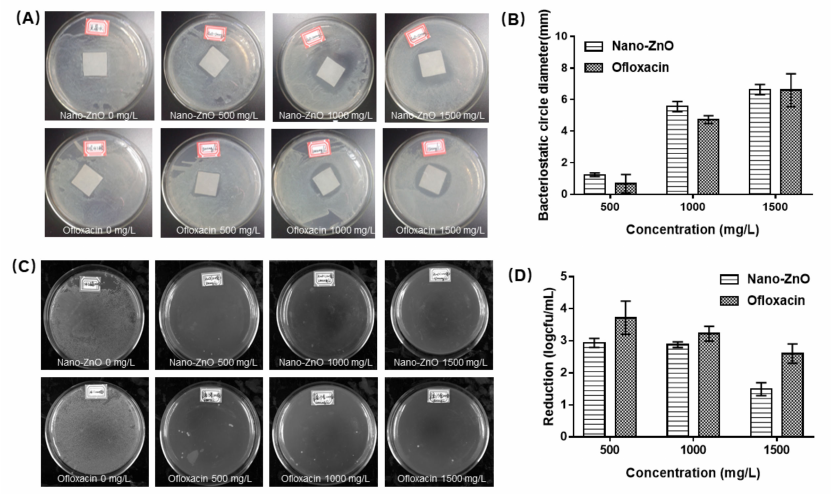
Figure 1. Antibacterial effect of Nano-ZnO on S. aureus : ( A ) inhibition circle of Nano-ZnO and ofloxacin, ( B ) quantitative column chart of ( A ), ( C ) single colony formation of Nano-ZnO and ofloxacin, ( D ) quantitative column chart of ( C